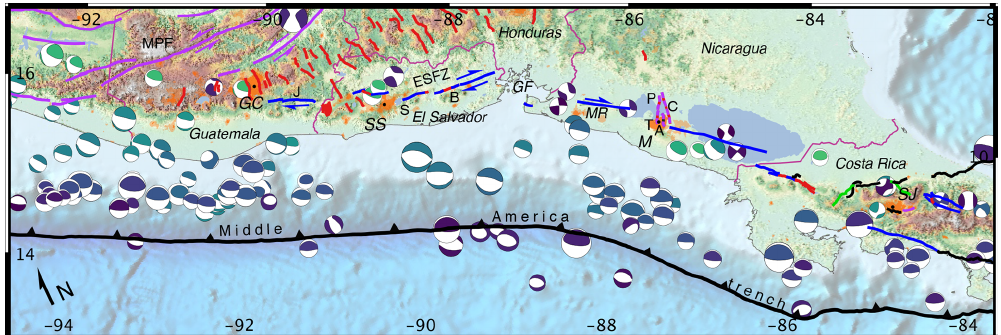
Figure 5. The Central American forearc. MPF is the Motagua–Polochic fault zone. J is the Jalpatagua fault. ESFZ is the El Salvador fault zone. S is the San Vicente segment (ESFZ). B is the Berlin Segment (ESFZ). P is the Punta Huete fault. C is the Cofradía fault. A is the Aeropuerto fault. T is the Tiscapa fault. GC is Guatemala City. MR is the Marabios range. M is Managua. SH is San